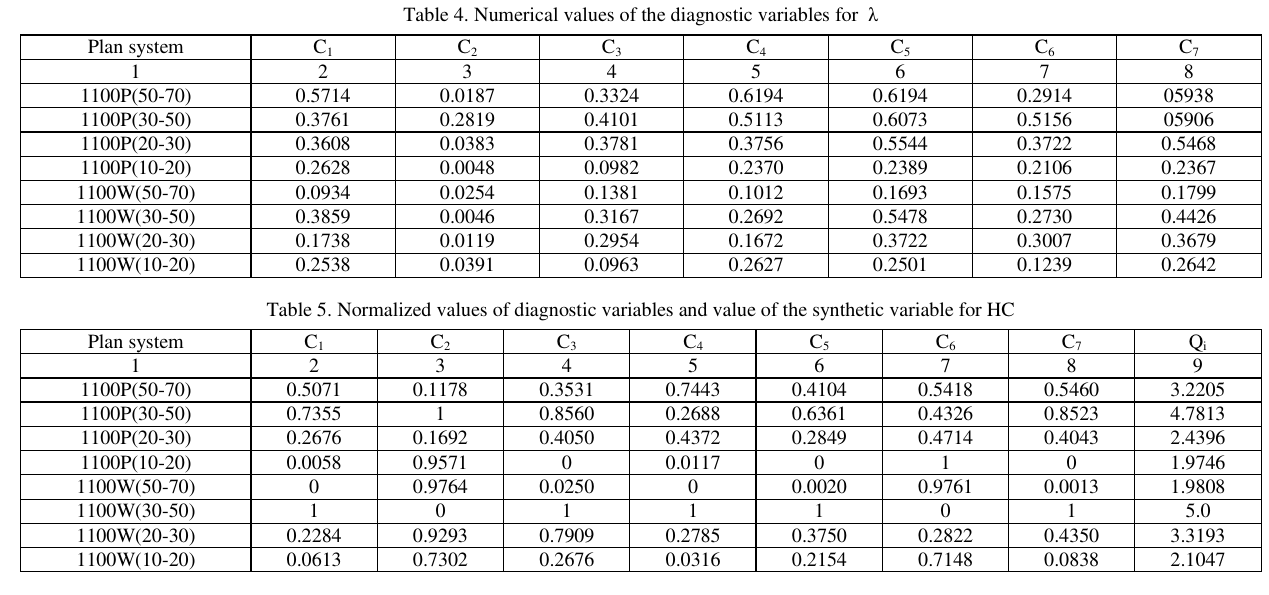
Table 6. Normalized values of diagnostic variables and value of the synthetic variable for CO